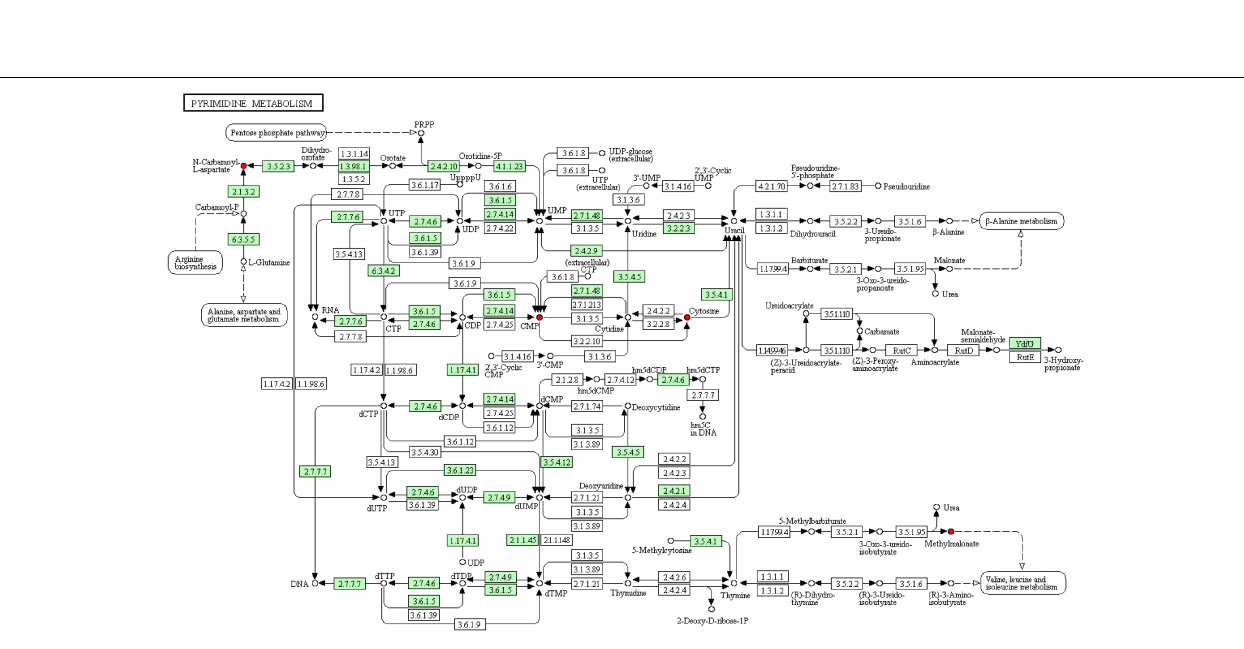
FIGURE 7 | The relationship among some significantly changed pathways and differential metabolites involved in each metabolic pathway. Metabolites in red indicate lower concentration, while metabolites in blue show enhanced levels.